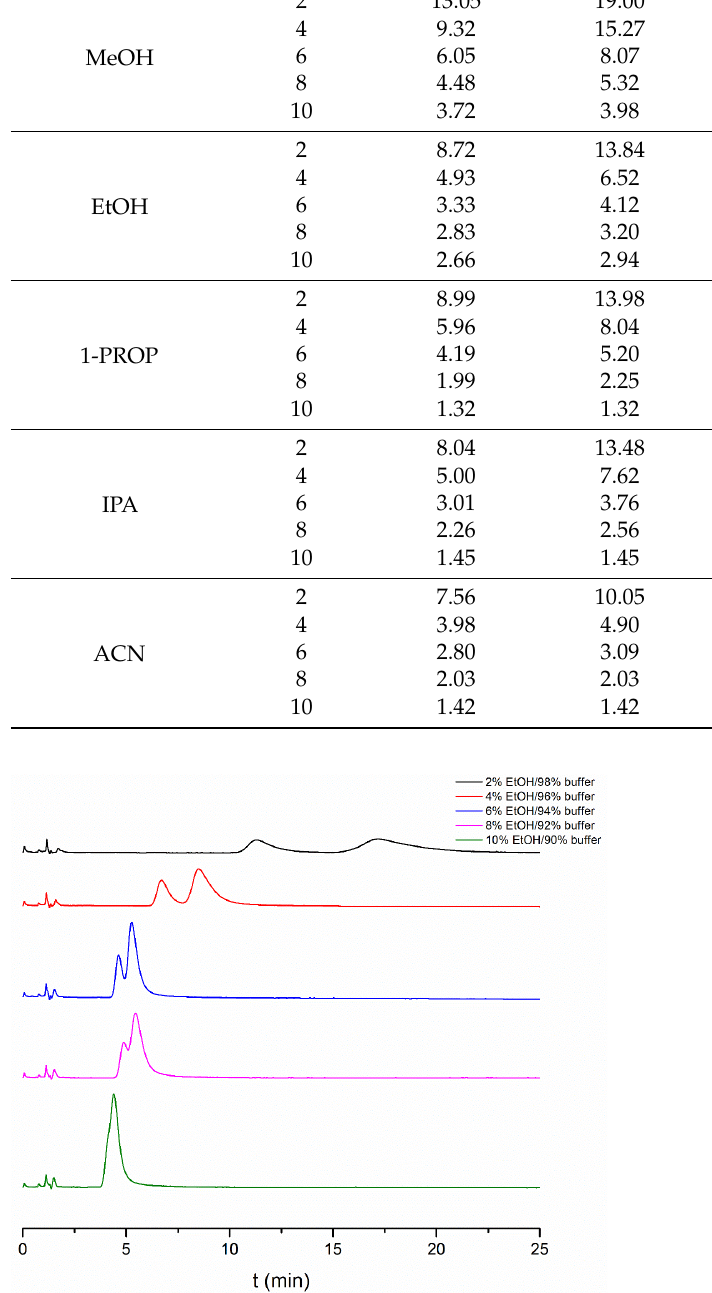
Figure 2. Effect of EtOH content in the mobile phase on enantioseparation of APR enantiomers. Chromatographic conditions: Chiral-HSA column, thermostated at 25 ◦ C, flow rate 0.7